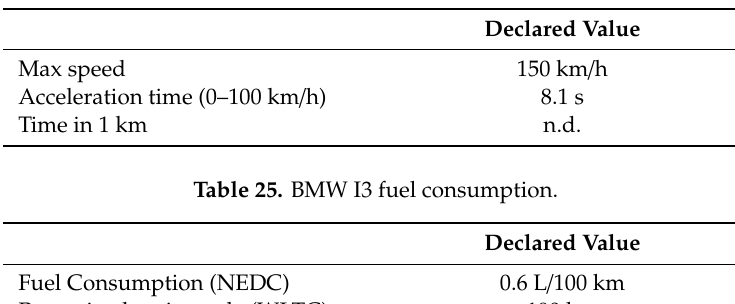
Table 24. BMW I3 performance characteristics.